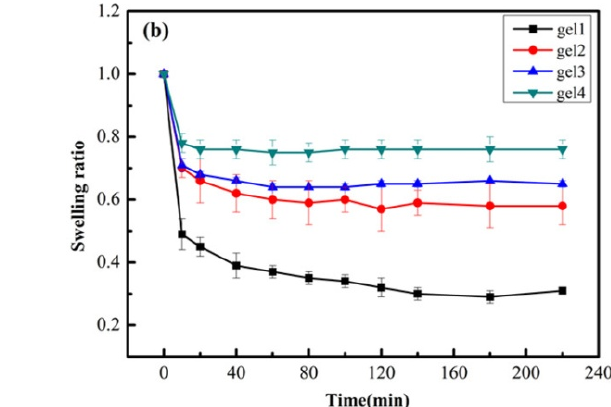
Figure 5. ( a ) Swelling curve of the hydrogels at 25 ◦ C, ( b ) de − swelling curve of the hydrogels at 37 ◦ C.